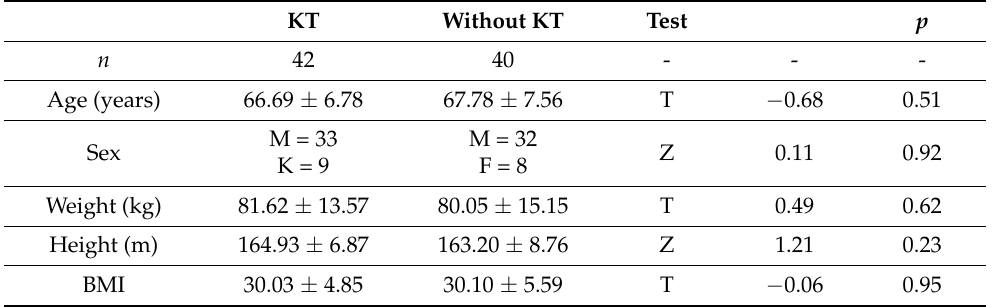
Table 1. Patients characteristics.